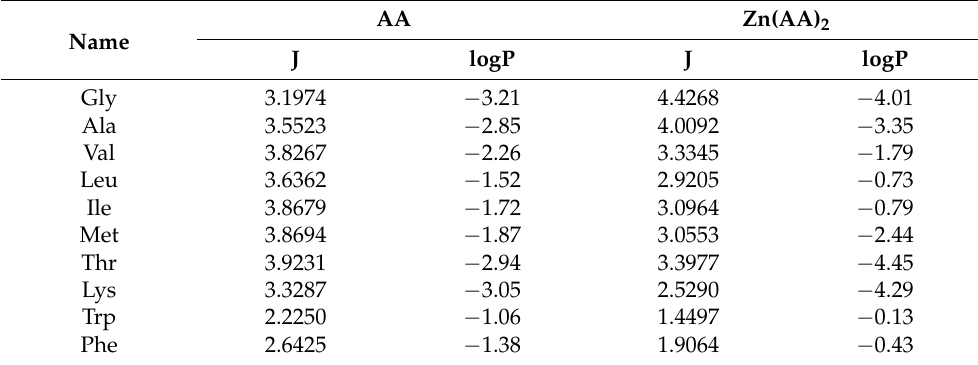
Table 1. The values of Balaban index (J) and logP for the studied amino acids and their zinc chelate